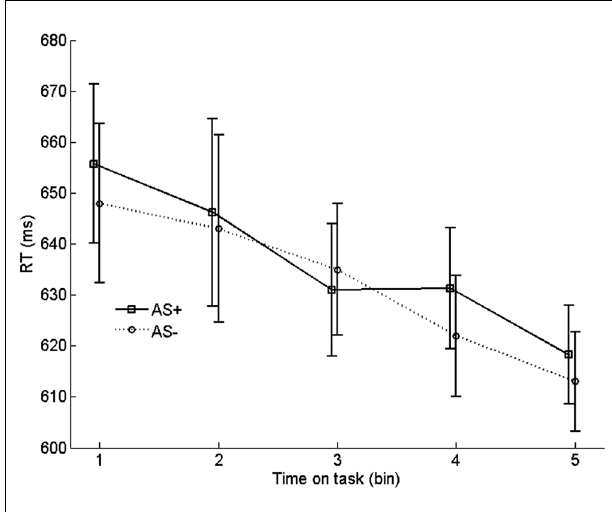
FIGURE 6 | Binned RTs on no-AS trials for stimuli that were frequently accompanied by an accessory stimulus (AS + ) vs. stimuli that were never accompanied by anAS (AS − ). Error bars are based on within-subjects error terms associated with each of the five pairwise comparisons (Masson and Loftus,